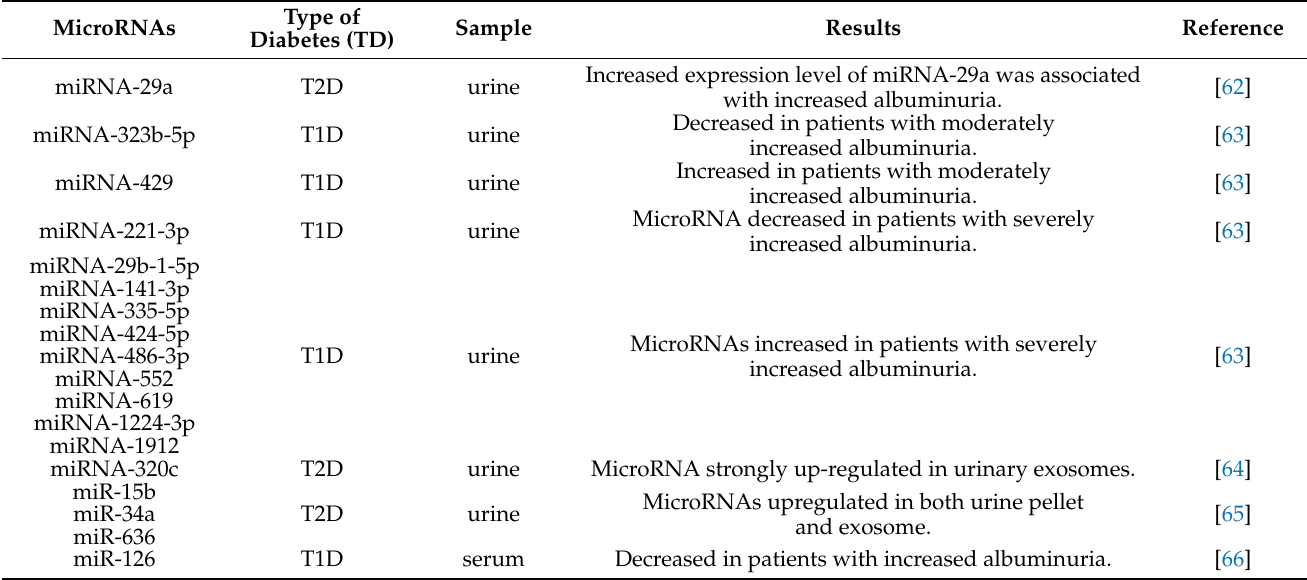
Table 3. Expression of selected microRNAs in patients with diabetic kidney